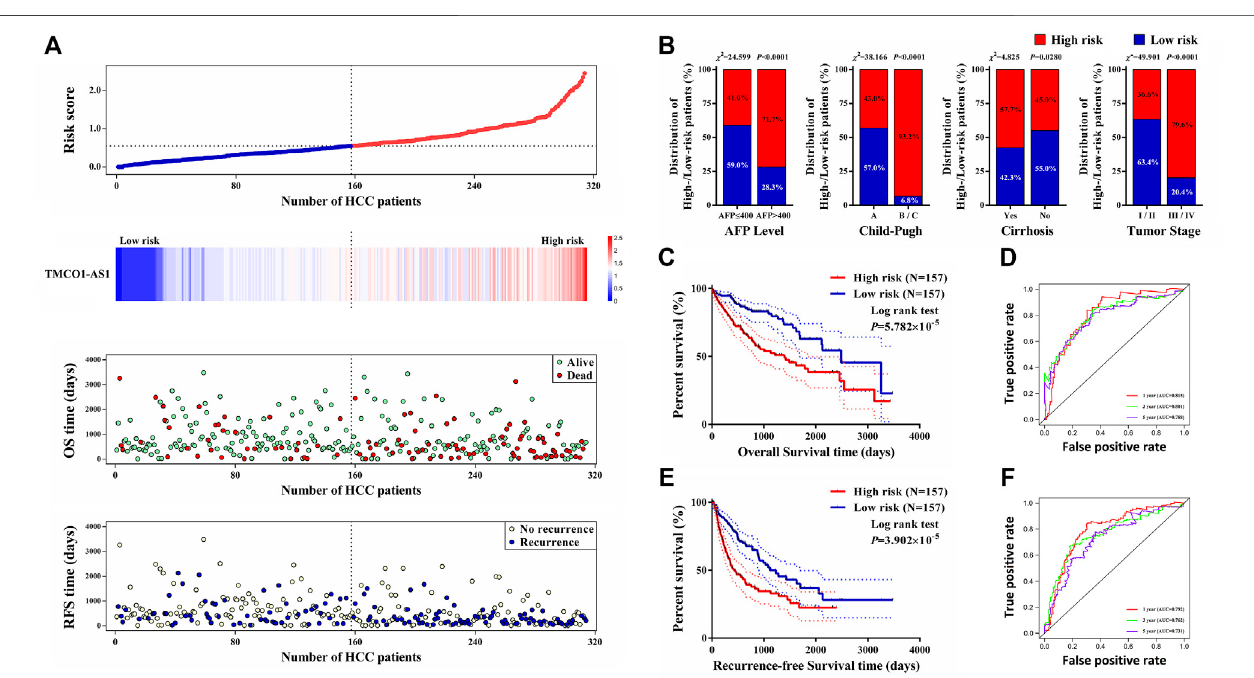
FIGURE 5 | A prognostic model for OS and RFS of HCC patients from TCGA. (A) Risk score distribution, TMCO1-AS1 expression, and OS and RFS of patients in thehigh-andlow-riskgroup. (B) Comparisonofthedistributionsofpatientswithdifferentcharacteristicsinthehigh-andlow-riskgroups. (C) Kaplan-MeierOScurvesfor patients in the high- and low-risk groups. (D) Time-dependence ROC curves of the risk score for OS. (E) Kaplan-Meier RFS curves for patients in the high- and low-risk groups. (F) Time-dependence ROC curves of the risk score for RFS.